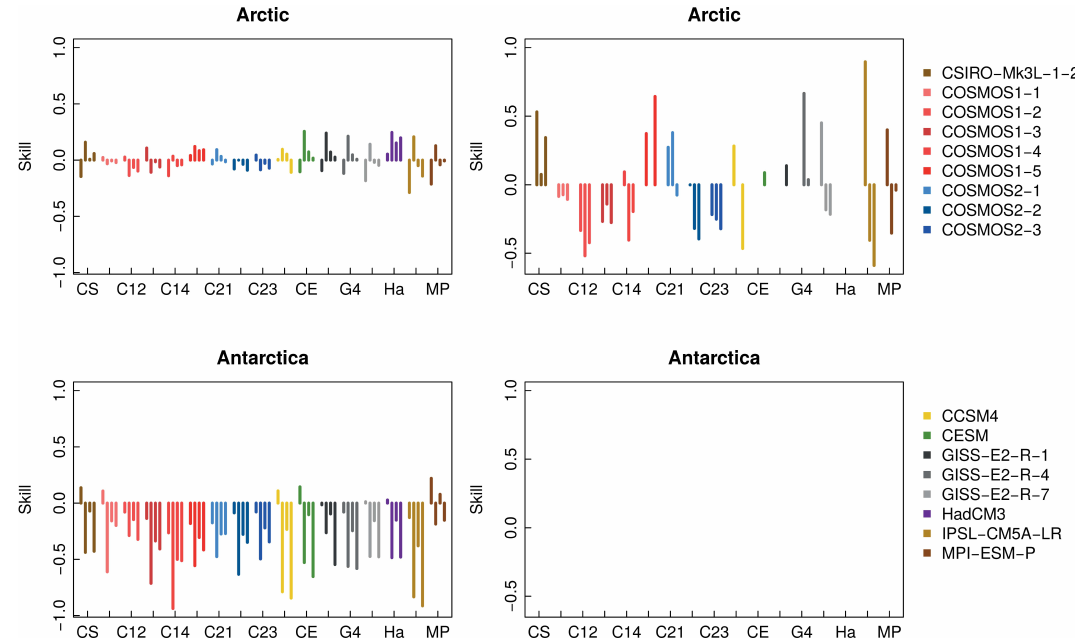
Figure 4. Skill metric for the individual models for all periods (from left to right: 850–1350, 1350–1850, 850–1850, 850–2000). Top row for the Arctic, bottom for Antarctica. The computations assume no uncertainties (left plot) and uncertainties provided with the original reconstructions (right plot). When the skill is undefined (as for Antarctica when using the original error estimates) no bar is shown. Positive values indicate skill in this simple evaluation.